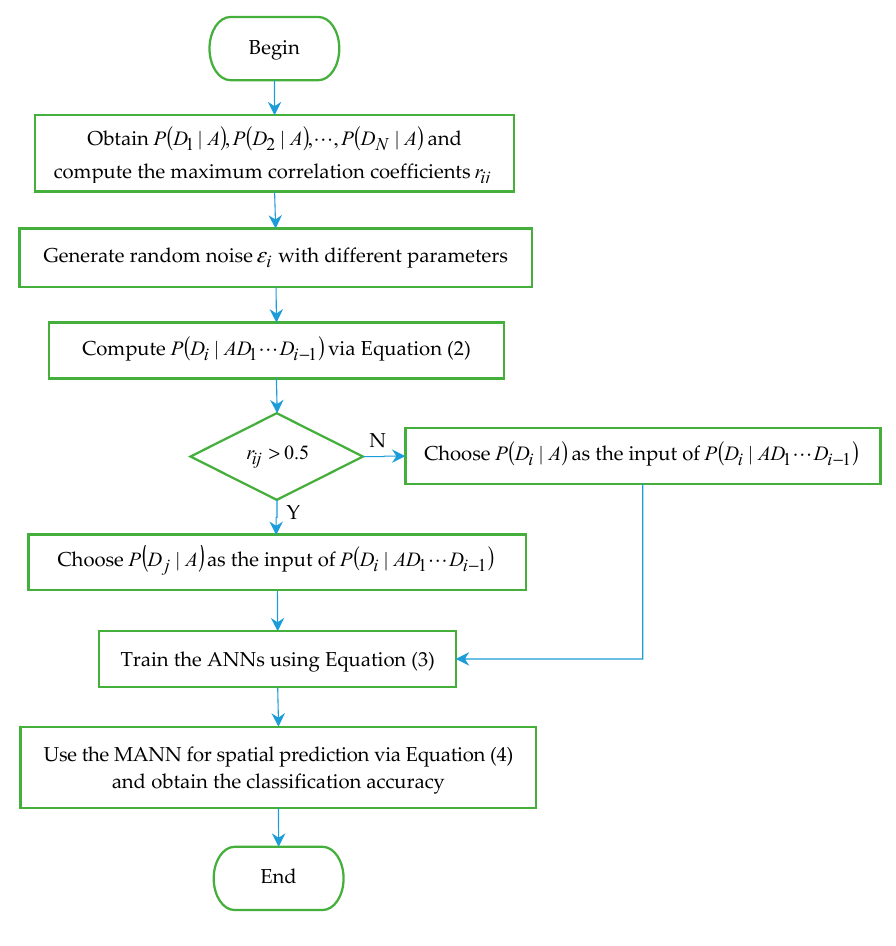
Figure 1. Flowchart of the proposed method.